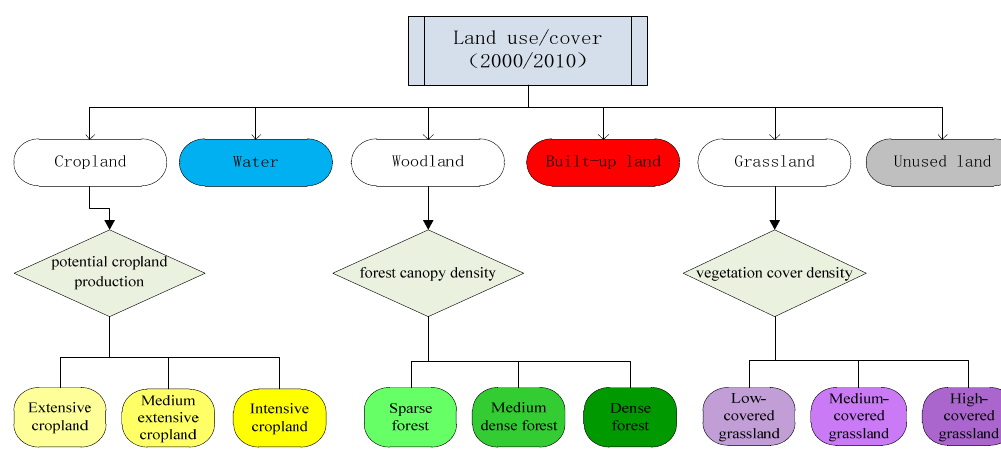
Figure 2. Research framework of this study.